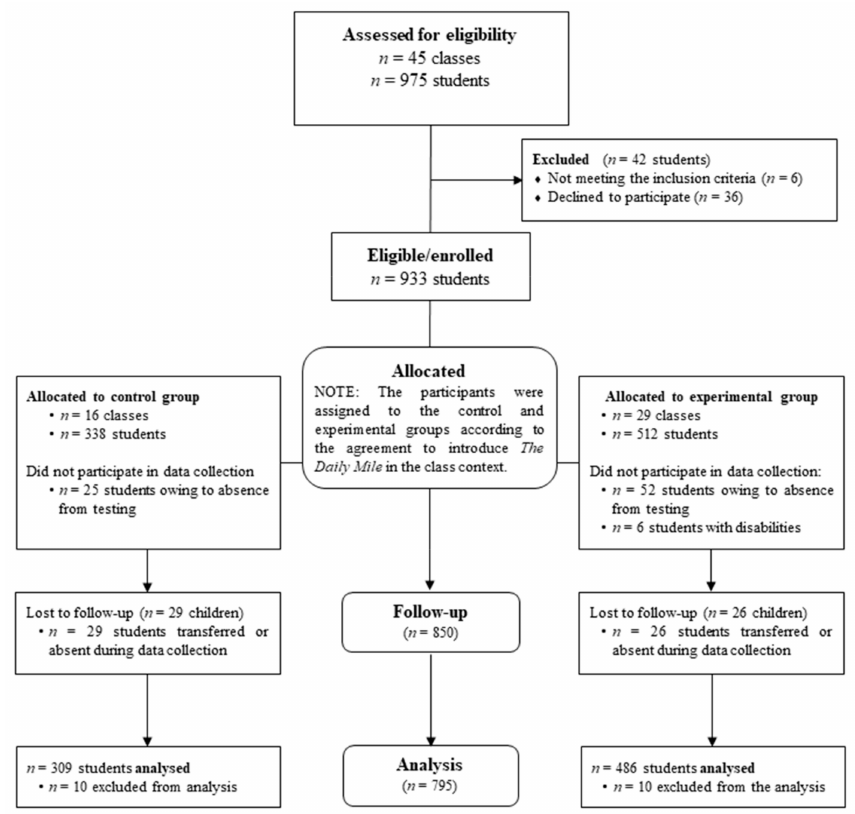
Figure 1. Recruitment process of the study